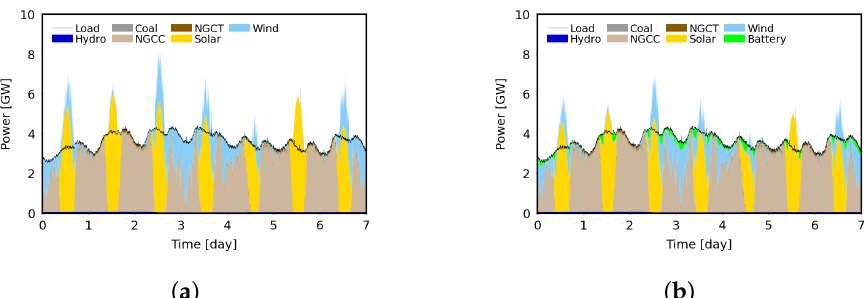
Figure 12. Example week of economic dispatch for in the critical month of January for a gas dominated system with for 6.5 GW solar PV and 3.25 GW wind capacity with ( a ) dispatch with pre-defined weather data and ( b ) reduction in VRE output by 15% post-dispatch and battery energy storage for matching load demand.